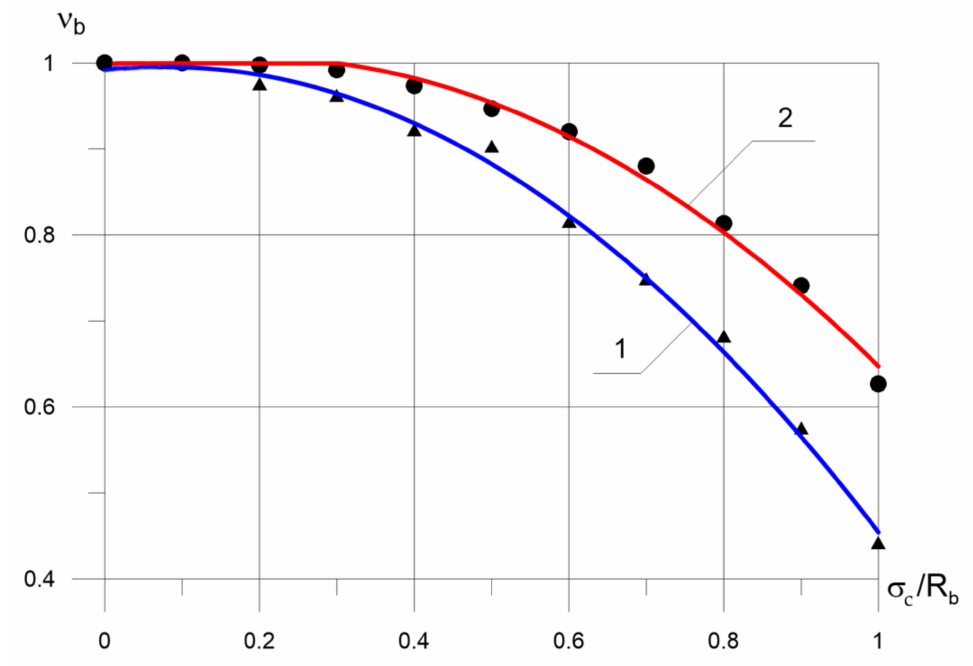
Figure 4. Dependence of the coefficient of elastic–plastic strains ν b on the growth of stresses in expanded clay concrete (1) and expanded clay FRC (2). ν b = ε e / ε b —coefficient of elastic–plastic strains of concrete, ε e —elastic concrete strain; ε b —total concrete